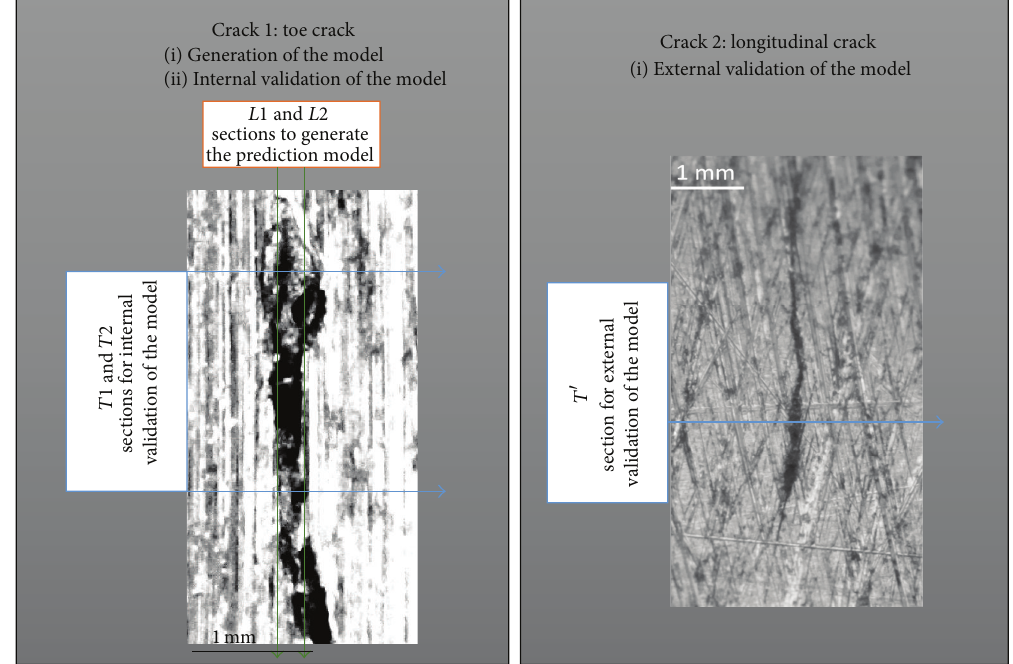
Figure 4: Cracks with sections used to generate the model ( 𝐿1 and 𝐿2 ), internal validation ( 𝑇1 and 𝑇2 ), and external validation ( 𝑇 󸀠 ).